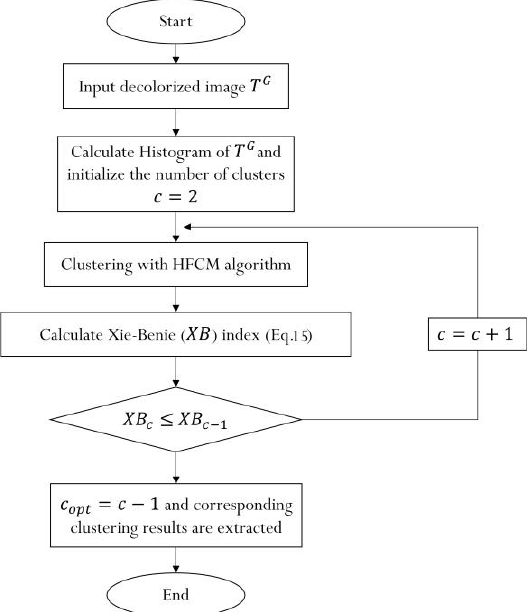
Figure 2. The flowchart for determining the optimal number of clusters using the histogram-based fuzzy C-means (HFCM) clustering algorithm.